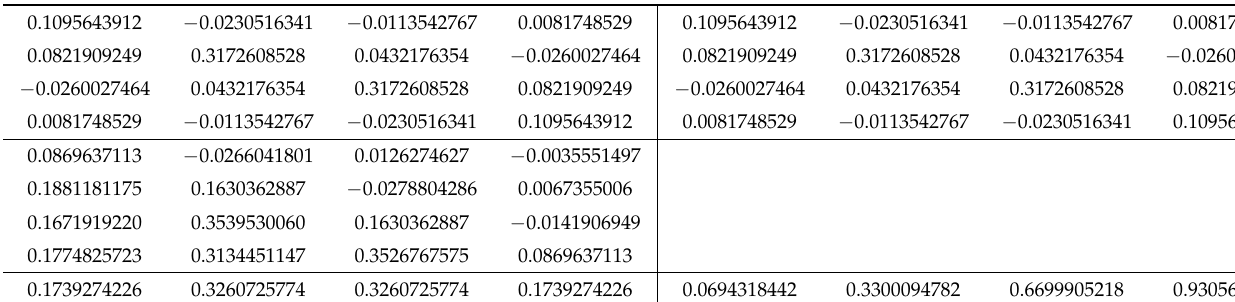
Table A12. G4|G4 method.